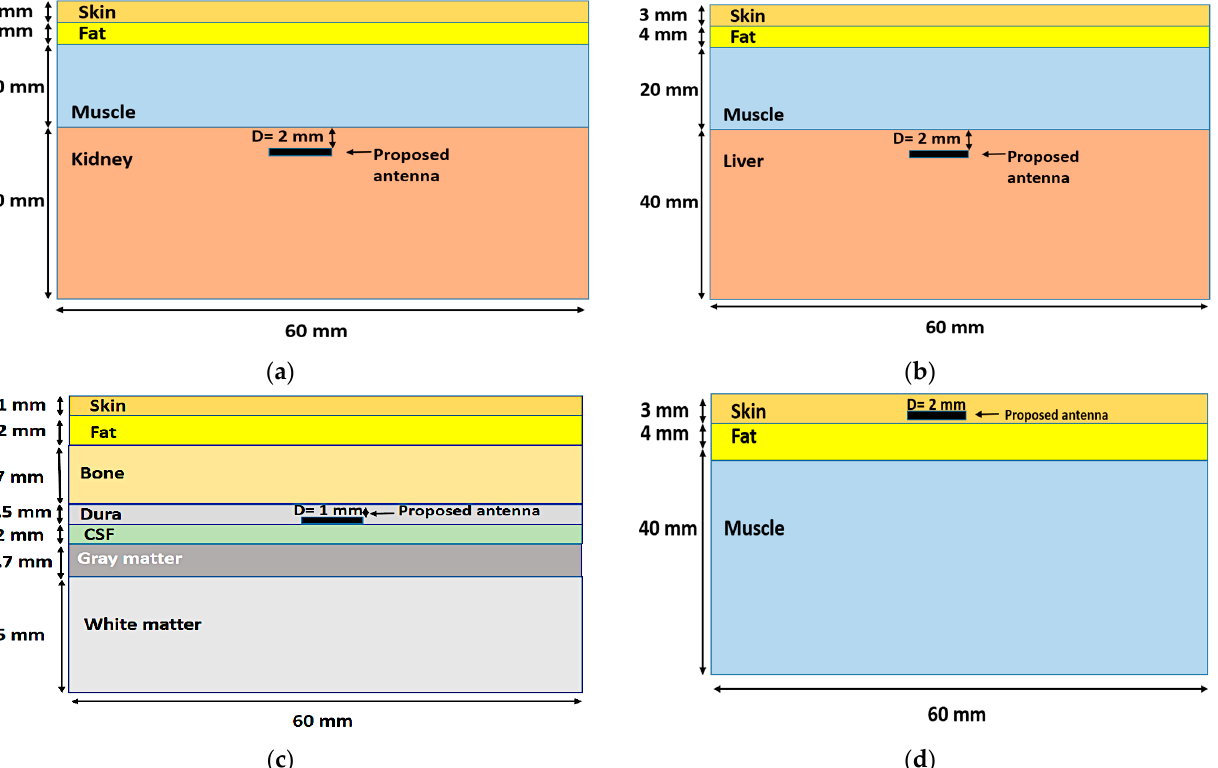
Figure 11. Realistic heterogeneous model mimicking the human body. ( a ) Four-layer kidney model; ( b ) four-layer liver model; ( c ) seven-layer brain model; ( d ) human body model. In the case of implanting the antenna in the liver, the simulation model consisted of four layers (skin, fat, muscle, and liver) [47]. The proposed antenna was placed 2 mm from the liver layer surface and 29 mm from the air, as shown in Figure 11b. The brain model consisted of seven layers (skin, fat, bone, dura, cerebrospinal fluid (CSF), and grey and white matter); the layer dimensions and implanting depth were mentioned in [48]. The proposed antenna was placed 1 mm from the dura layer surface and 11 mm from the air, as shown in Figure 11c,d.The human tissue consisted of three layers: skin, fat, and muscle